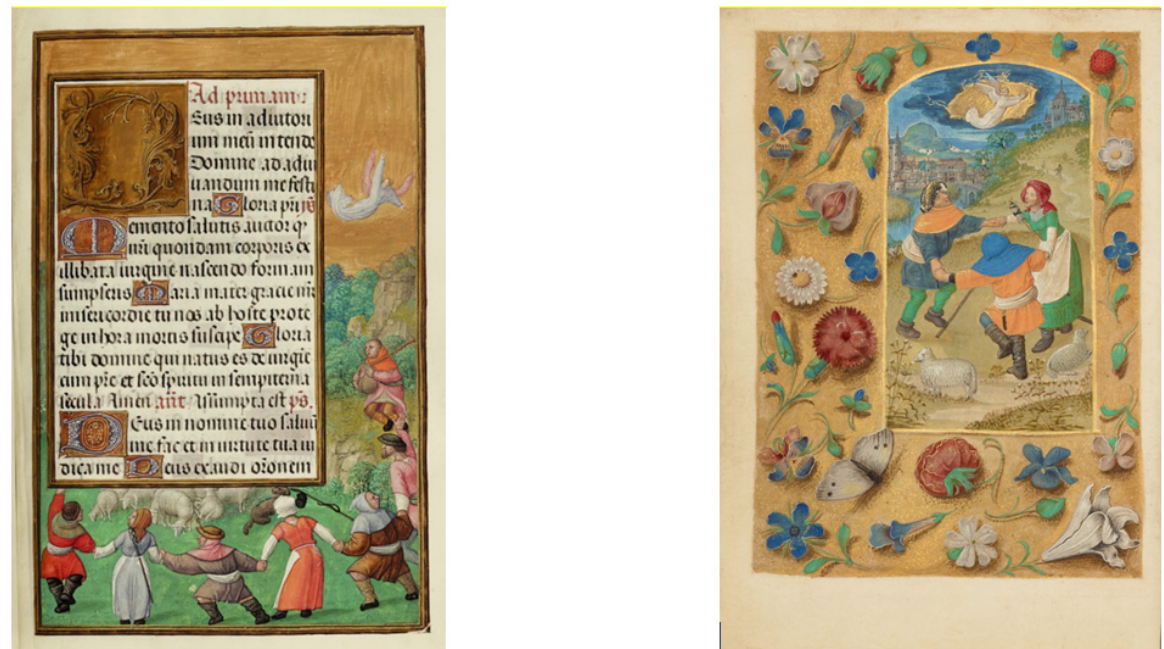
Figure 2. Fra Angelico was commissioned to do two different The Last Judgement altarpieces. This image shows parts of the piece which was commissioned for the Camaldolese Order (1425–1430) and is situated in Florence, Italy.